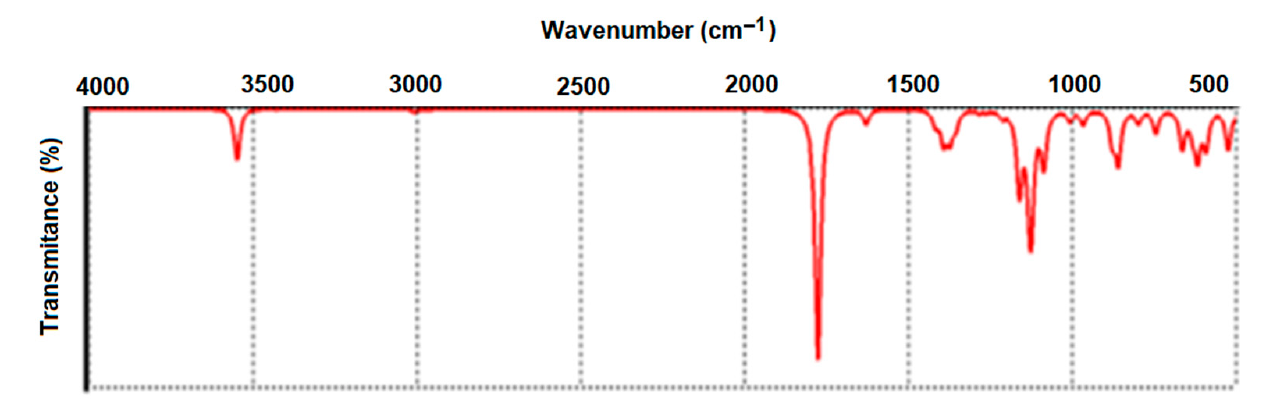
Figure 8. Simulated vibrational spectrum of aspartic acid (Density Functional).